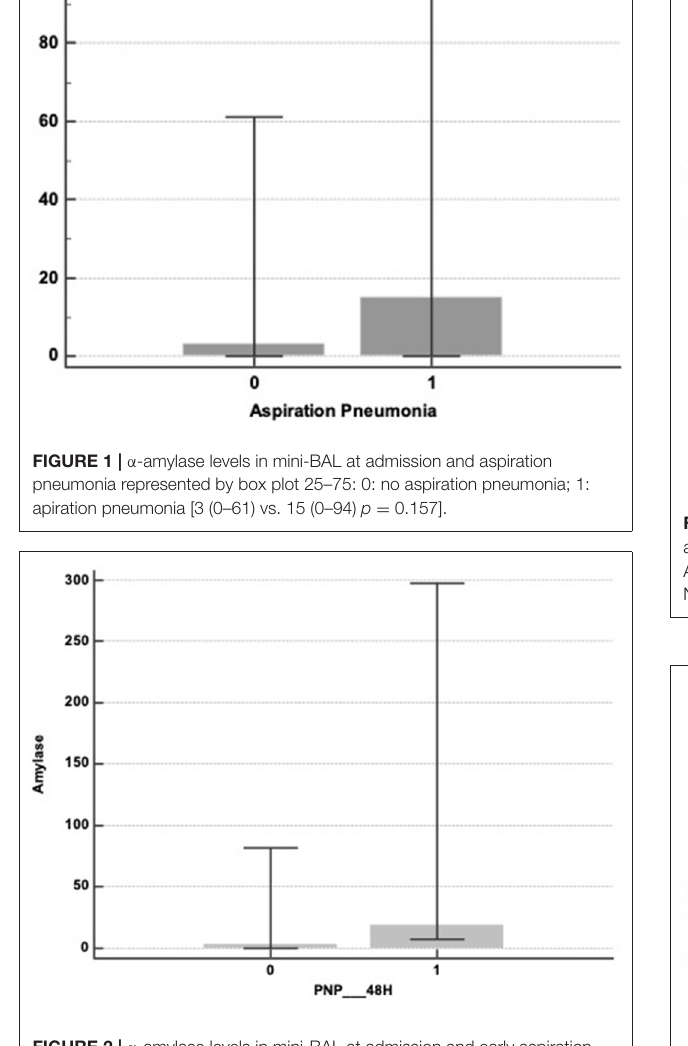
FIGURE 2 | α -amylase levels in mini-BAL at admission and early aspiration pneumonia (within the first 48h) represented by box plot: 0: no early aspiration pneumonia; 1: early apiration pneumonia [19 (7–297) vs. 3 (0–82)— p = 0.047].